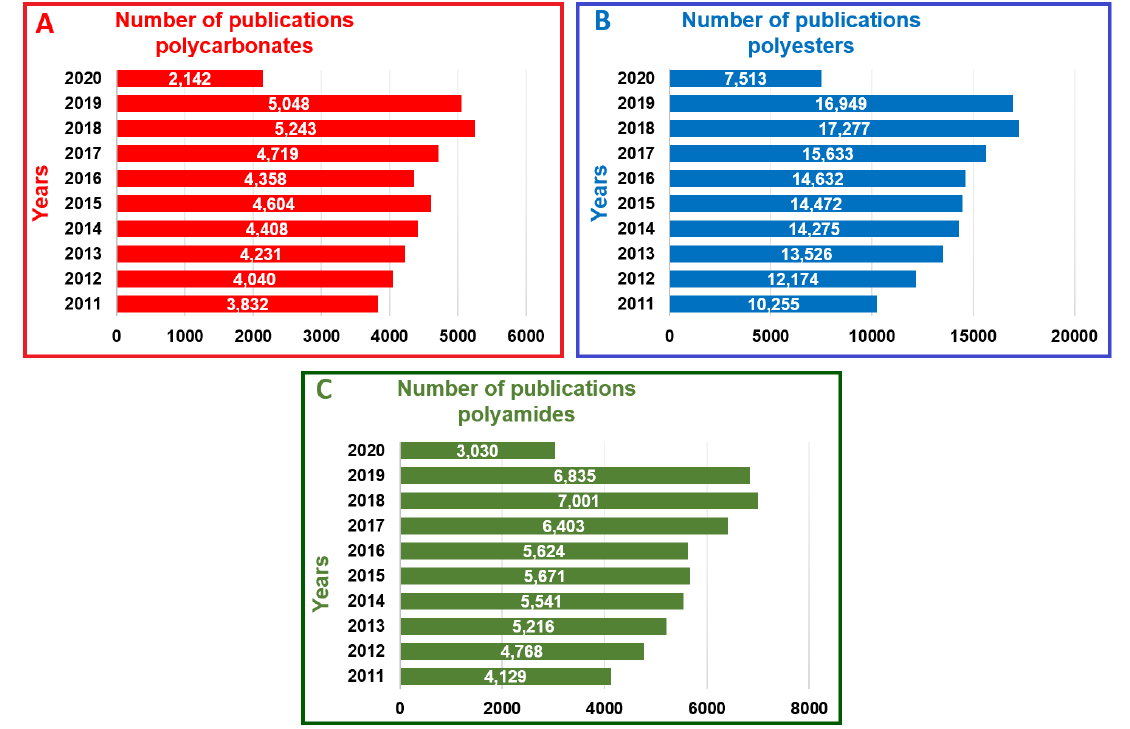
Figure 3. Articles published in the last 10 years related to: ( A ) polycarbonates; ( B ) polyesters; and ( C ) polyamides. These numbers were generated from the “Web of Science database” using the keywords “polycarbonates” for ( A ), “polyesters” for ( B ), and “polyamides” for ( C ). (Date data acquired: 15 July 2020).